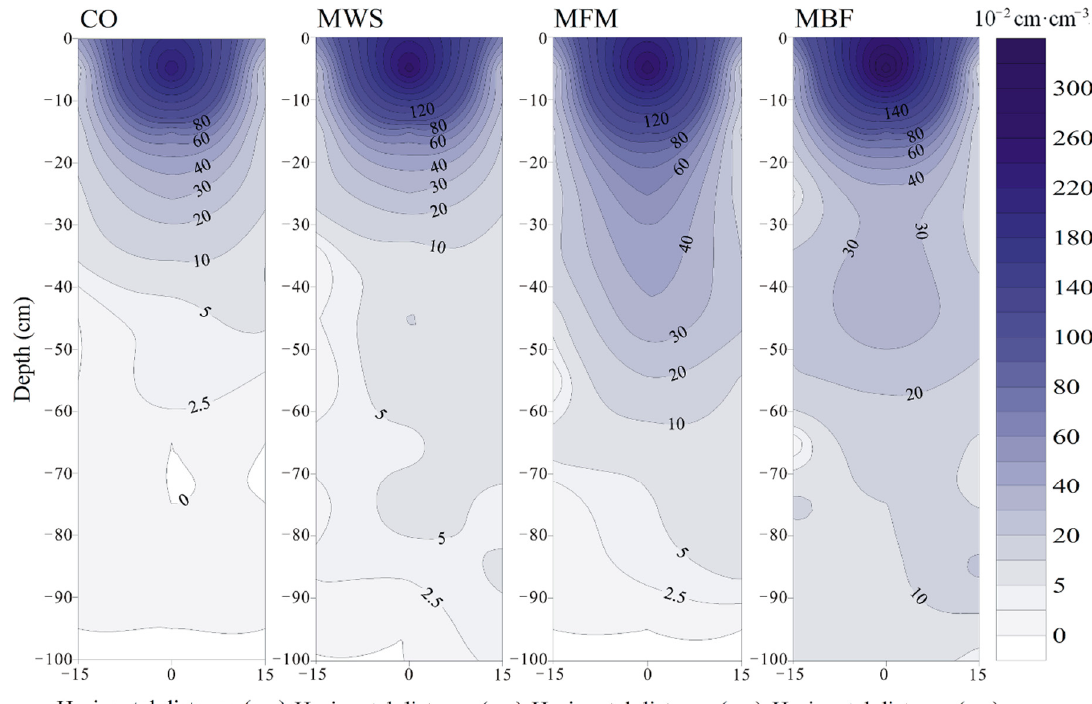
Figure 5. Two-dimensional distributions of the mean root-length density in the 0–100 cm layer under indicated treatments at maturity averaged over two years. The abbreviations of the treatment names are the same as those described in Figure